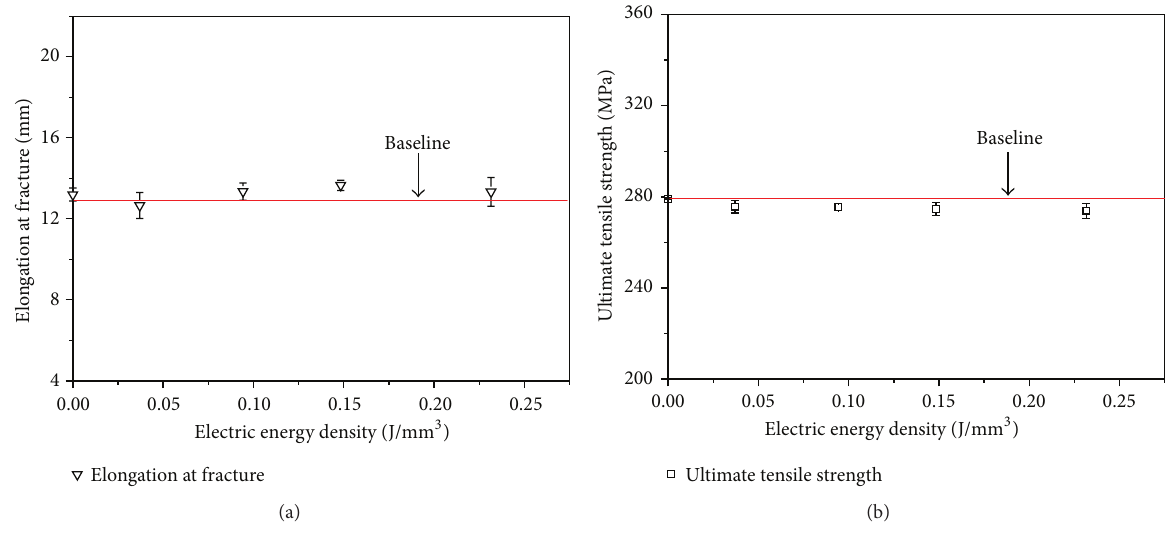
Figure 6: (a) The elongation at fracture and (b) the UTS as functions of the electric energy density.